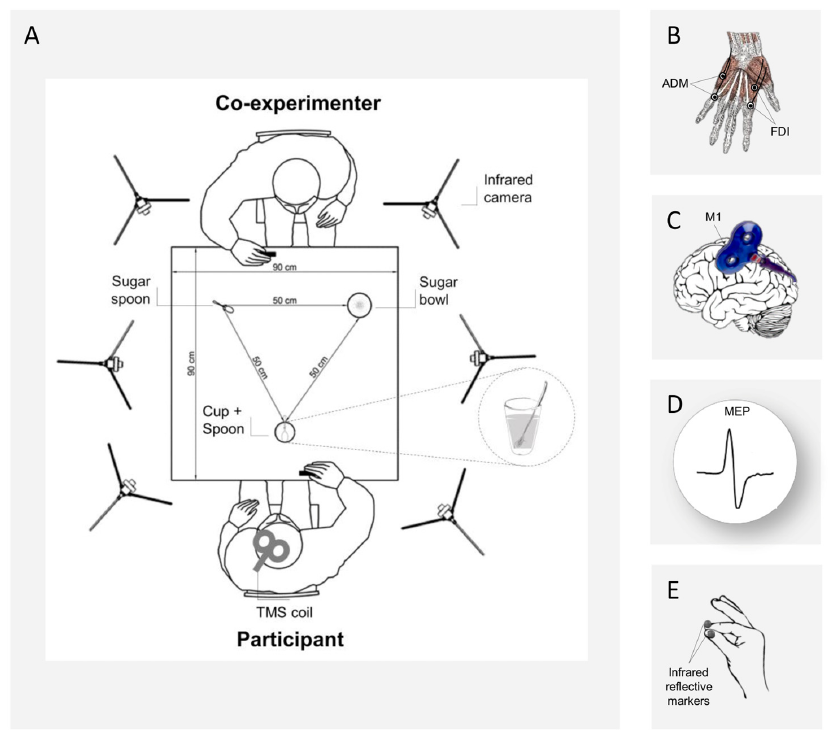
Figure 1. ( A ) Experimental setup. A 3 ‐ D Optoelectronic SMART ‐ D system was used to track the participant’s and co ‐ experimenter’s right hands kinematics by means of six infrared cameras. They sat in front of each other on opposite sides of a table. A sugar spoon and a sugar bowl were placed close to the co ‐ experimenter, while a cup full of coffee with a spoon inside was placed close to the participant’s hand. ( B ) The EMG activity of the FDI and ADM hand muscles was recorded through two pairs of surface electrodes. ( C ) A TMS coil placed on the participant’s left M1 was used to investigate corticospinal excitability during action preparation and ( D ) TMS ‐ induced MEPs were recorded. ( E ) Two infrared reflective markers were taped to the participant’s index and thumb fingers and a third was taped on the co ‐ experimenter’s wrist for kinematic recordings.